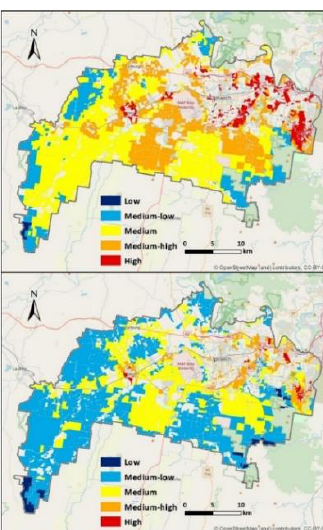
Figure 2 . Suitability maps of scenario residential development.